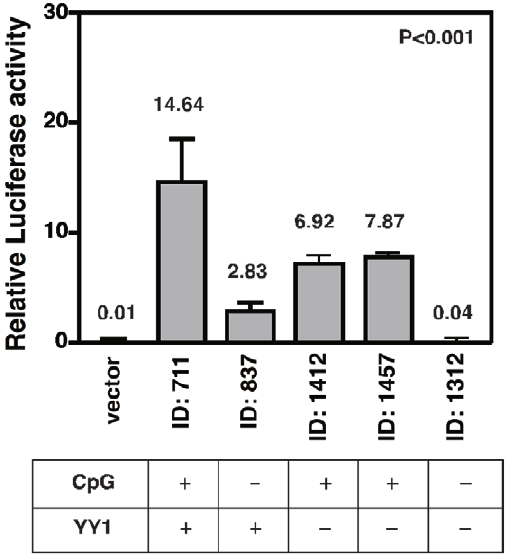
Table S1 The statistical analysis of the number of monomers in three L1 subfamilies.